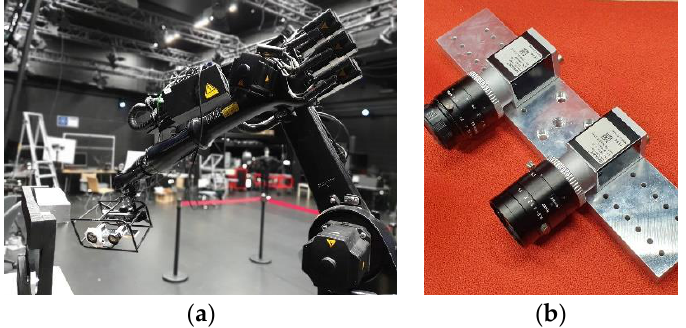
Figure 2. An example of the setup for acquiring the datasets; ( a ) robotic arm moving in the workspace; ( b ) cameras and Lenses for data acquisition.